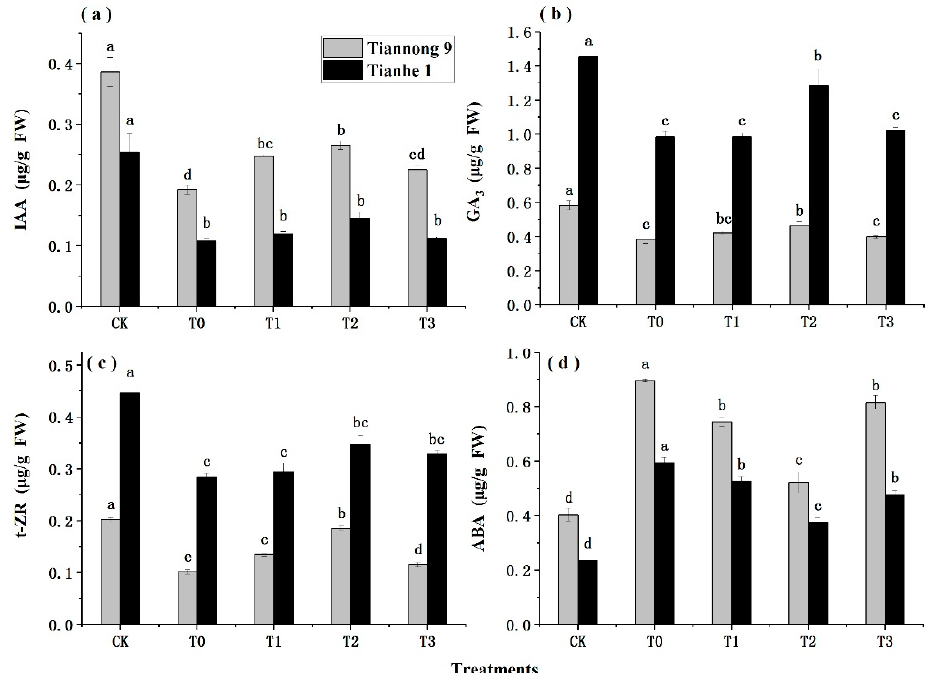
Figure 4. Effects of different concentrations of BL on plant hormones of maize seedlings under chilling stress. CK treatment at 25 °C with distilled water, T0 treatment with BL at 0.00 mg/L, T1 treatment with BL at 0.01 mg/L, T2 treatment with BL at 0.1 mg/L, T3 treatment with BL at 1 mg/L. The data represent the means of independent measurements with three replicates. The mean values marked with different letters differ significantly at p < 0.05. ( a ) The variation trend of IAA content. ( b ) The variation trend of GA 3 content. ( c ) The variation trend of t-ZR content. ( d ) The variation trend of ABA content.